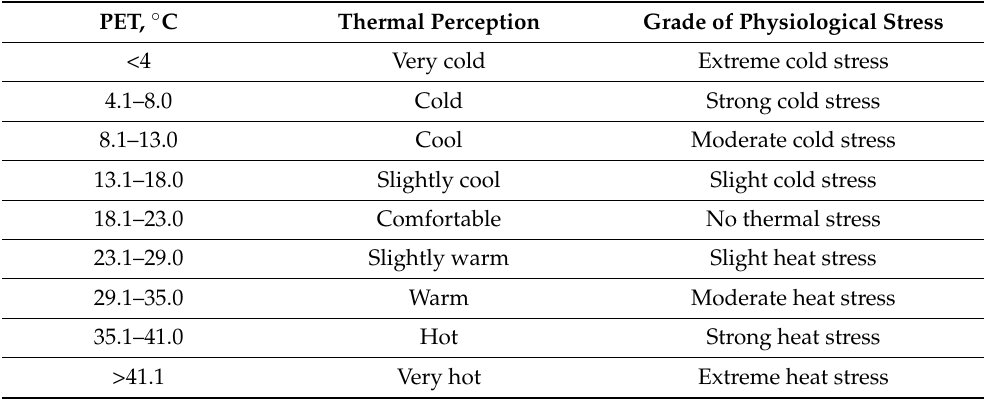
Table 1. Ranges of the physiologically equivalent temperature (PET) for different grades of thermal perception by human beings and physiological stress on human beings